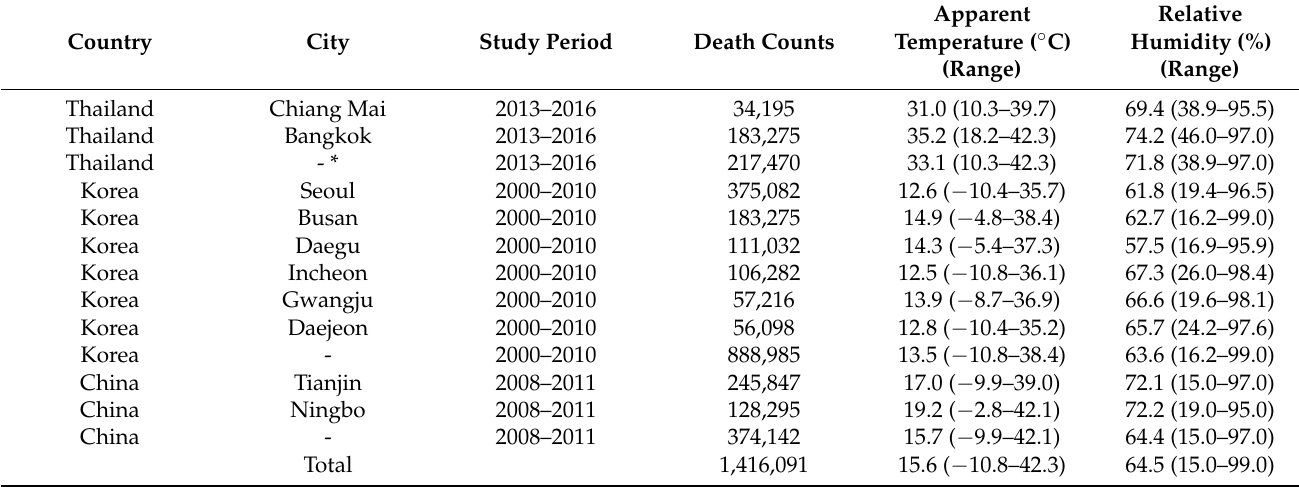
Table 1. Descriptive analysis of non-accidental daily death counts and meteorological variables in 10 Asian